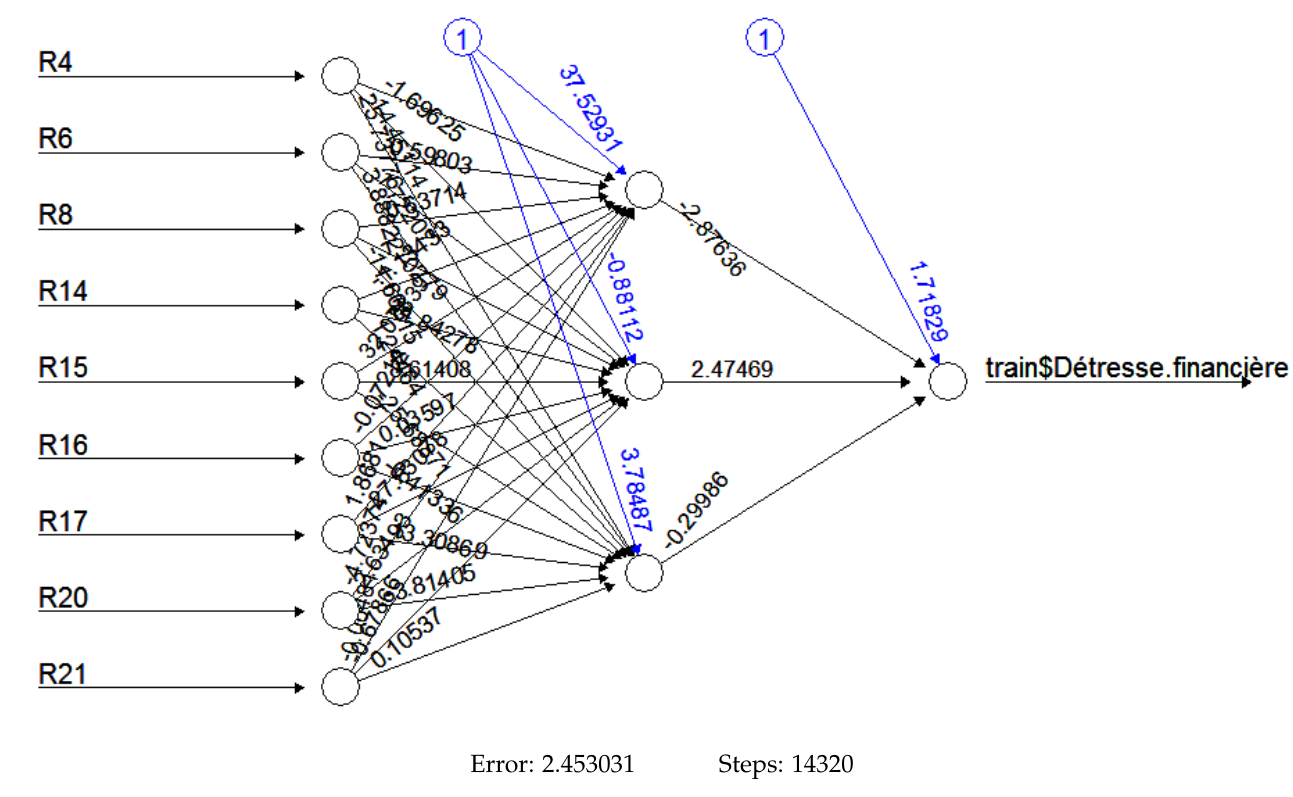
Figure A4. Neural networks model for lasso selection technique, year